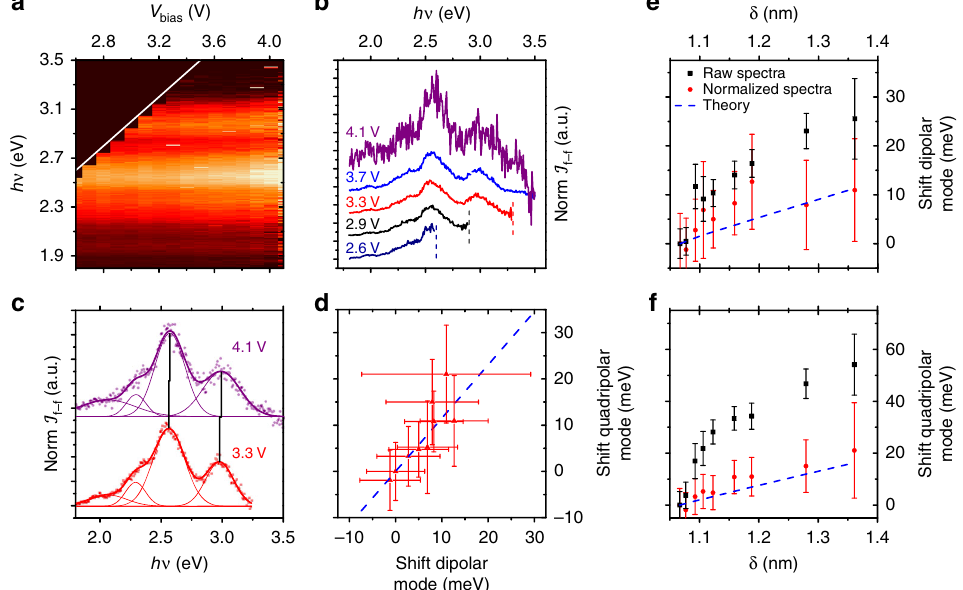
Fig. 5 Normalised STM spectra and the shifts of the plasmonic resonances. a Normalised light intensity emitted for a particular tip con fi guration as a function of the photon energy (vertical axis) and the stabilisation voltage (horizontal axis). Quantum cut-off is marked by a white line. b Individual spectra recorded for different stabilisation voltages. The quantum cutoff condition for each voltage (where relevant) is marked by a vertical line of the same colour as the spectra. The spectra have been vertically offset to enhance visibility. c Shift of the peak energies with bias voltage. The peak position has been extracted by fi tting the spectra to Gaussian peak shapes. d Proportionality between the energy shifts of the low- and high-energy peaks. The blue dashed line corresponds to the expected trend from our EM calculations. e , f Dipolar and quadrupolar mode shifts obtained from the raw spectra (black squares), the normalised spectra (red circles) and EM calculations (blue line) for gap sizes (tip-surface distances) estimated from the zero-bias conductance at different stabilisation voltages. Error bars in d – f correspond to the standard deviation from the Gaussian fi